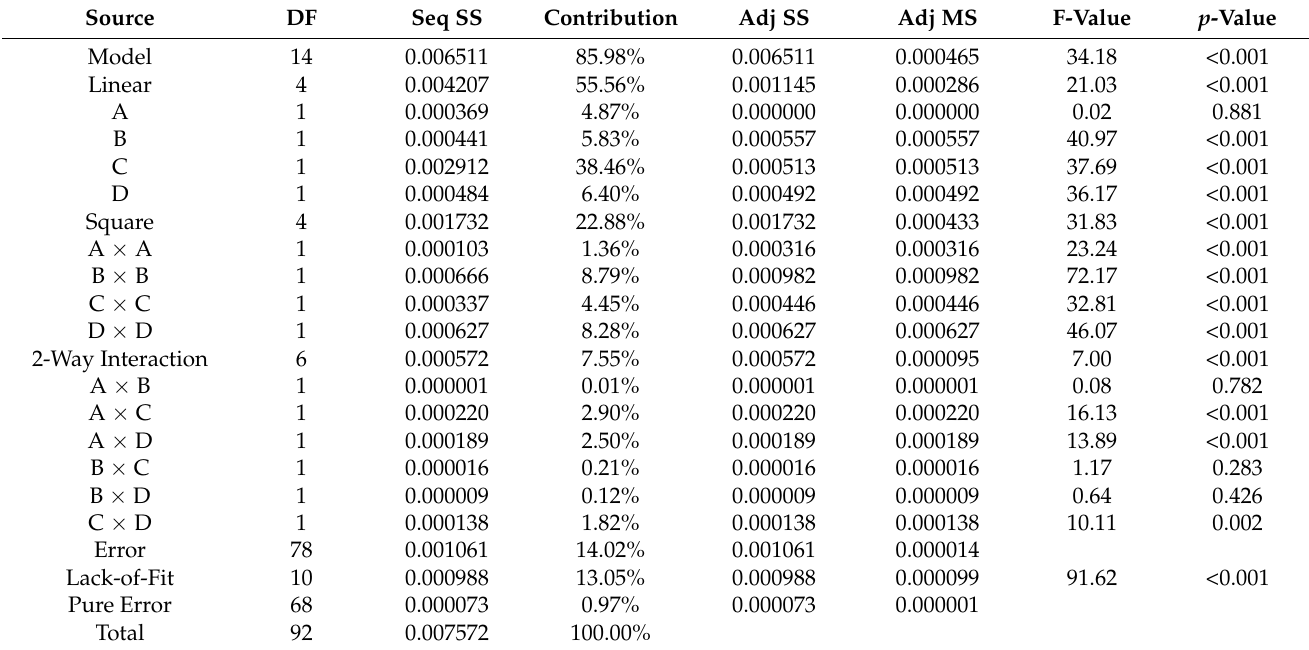
Table 12. The ANOVA table for RSM-CCD.